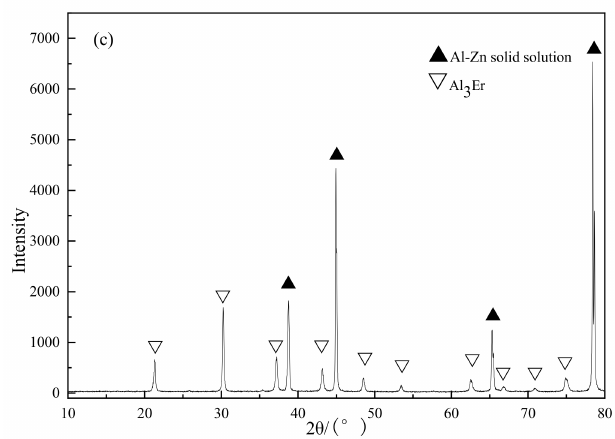
Figure 4. XRD analysis of Al–5Zn–0.03In– x Er alloys: ( a ) Al–5Zn–0.03In; ( b ) Al–5Zn–0.03In–1Er;